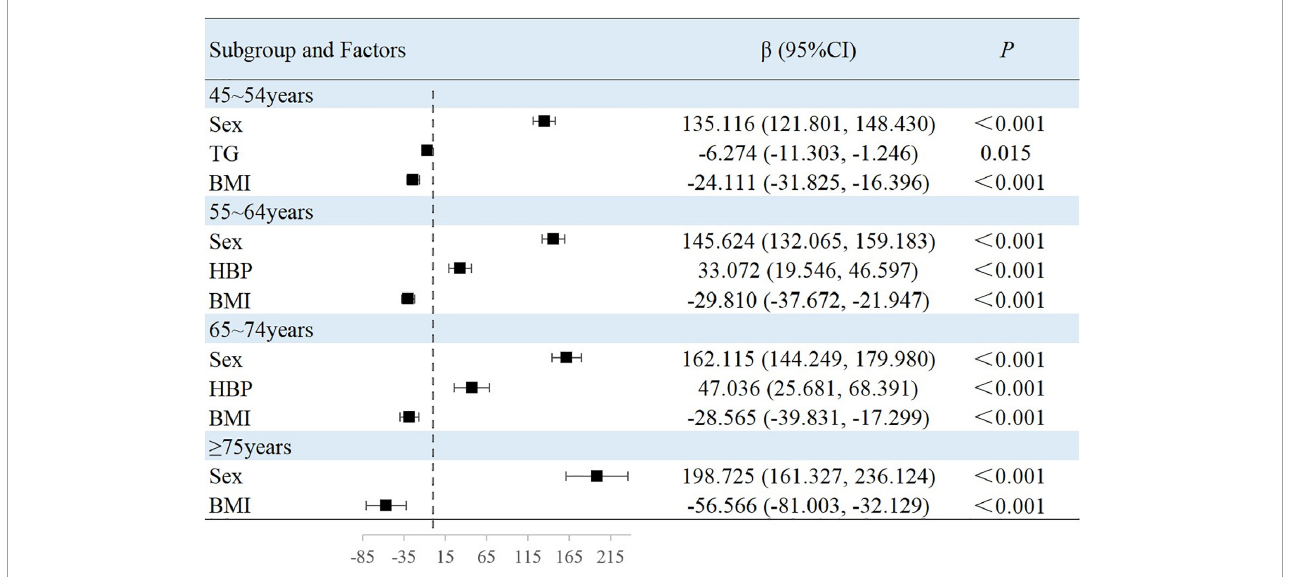
P < 0.001) lower and the mean BAC value was 0.011 ml/mmHg (95% CI, − 0.016 to − 0.006; P < 0.001) lower than in normotensive individuals. With each increase in the BMI level grouping, the mean BAR value decreased by 56.566 dyn s − 1 cm − 5 (95% CI, − 81.003